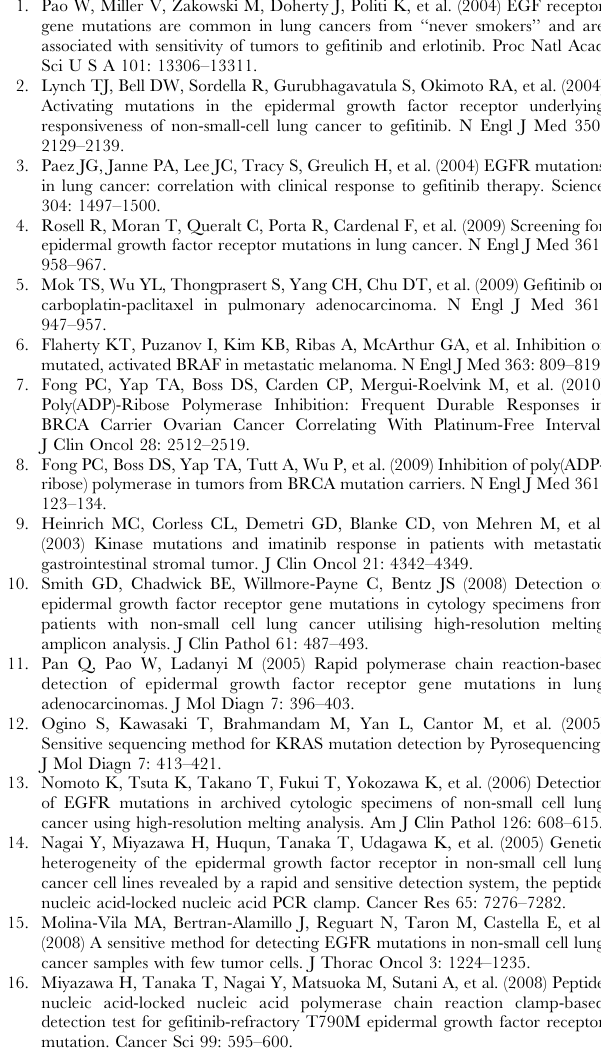
and KRAS mutation detection by three different sequencing technologies (dideoxy sequencing, pyrosequencing, parallel se- quencing) is